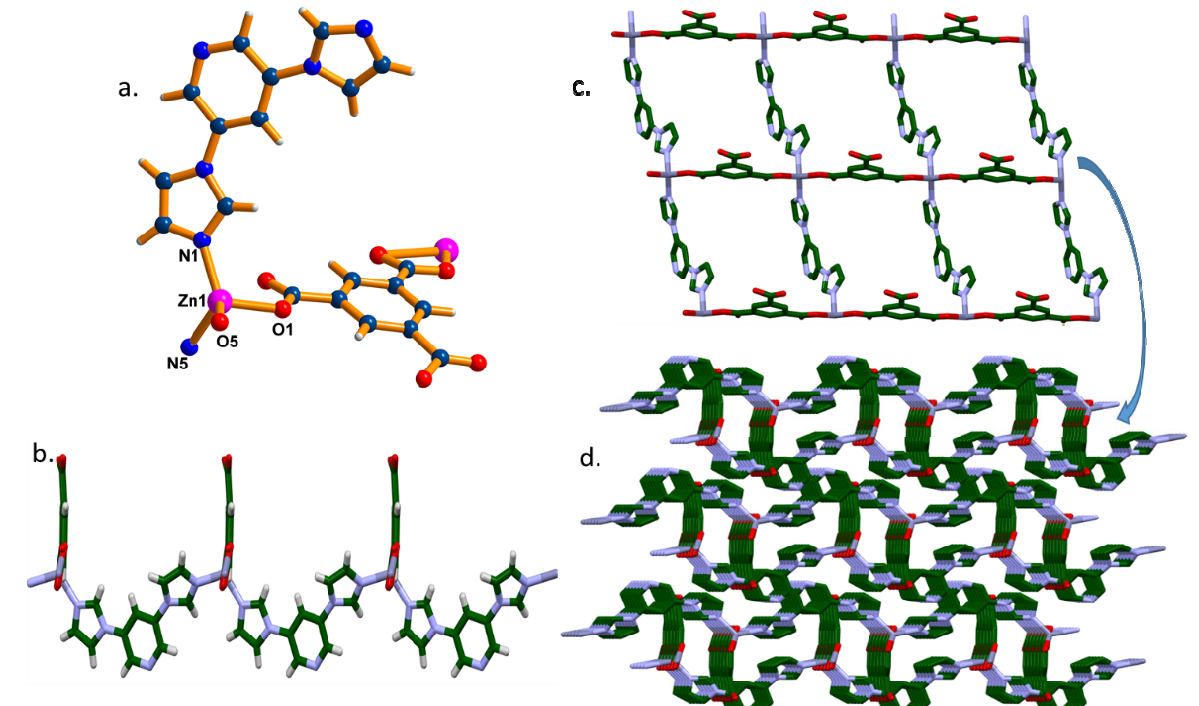
Figure 1. Schematic representations of the crystal structure of 1. ( a ) The coordination environment of the Zn(II) ions; ( b ) the infinite chain structure of 1; ( c ) view of 2D layer; and ( d ) view of 3D network along a direction.